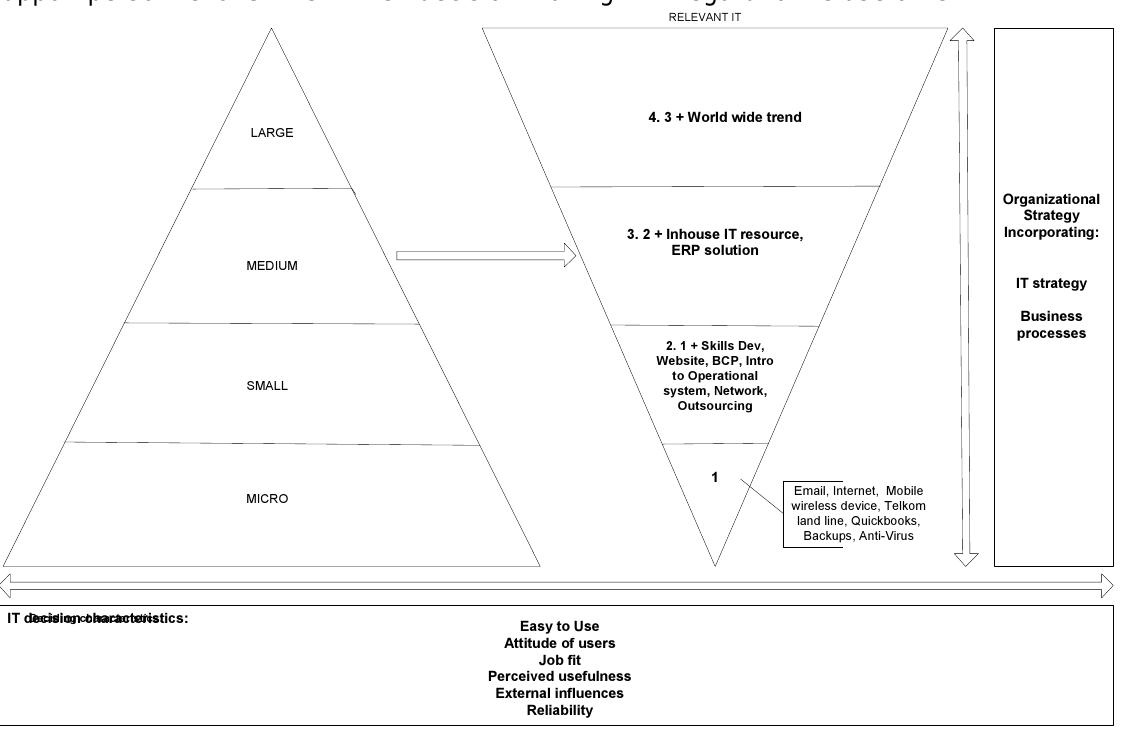
Figure 3: Conceptual framework for guiding SMEs in adoption of IT from a South African point of